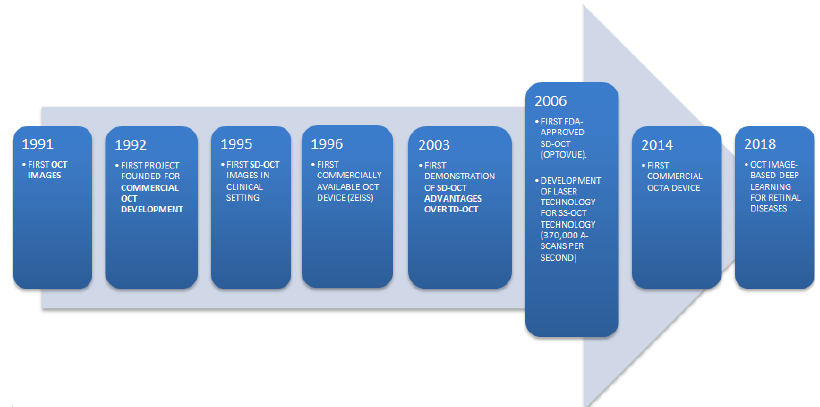
Figure 3. A timeline of optical coherence tomography (OCT) imaging. In 1991, David Huang was